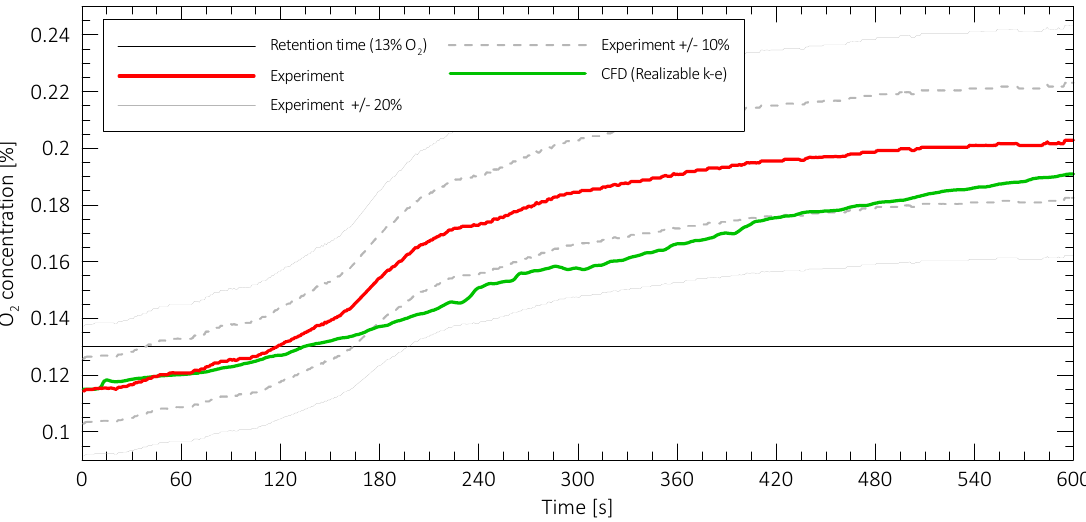
Figure 14. Changes in oxygen concentration (v/v) on the probe No. 5, indicating the end of the retention time during experimental tests and CFD simulations, fire-extinguishing gas Ar 0% v/v and N 2 100%